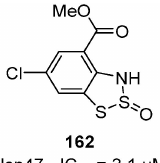
Figure 39. Hsp47 inhibitor methyl 6-chloro-3 H -benzo[ d ][1,2,3]dithiazole-4-carboxylate 2-oxide ( 162 ).